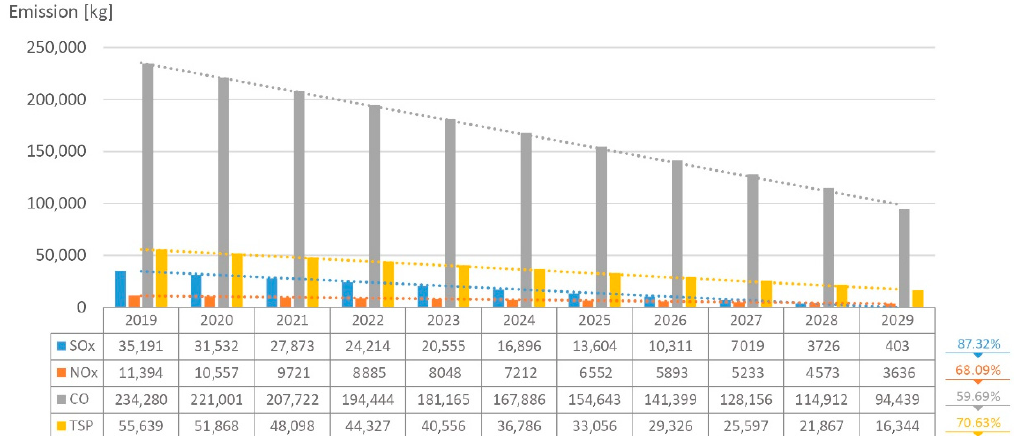
Figure 14. Change in pollutant emissions to the environment in the period 2019–2029, including the change in efficiency resulting from the implementation of Model 6.